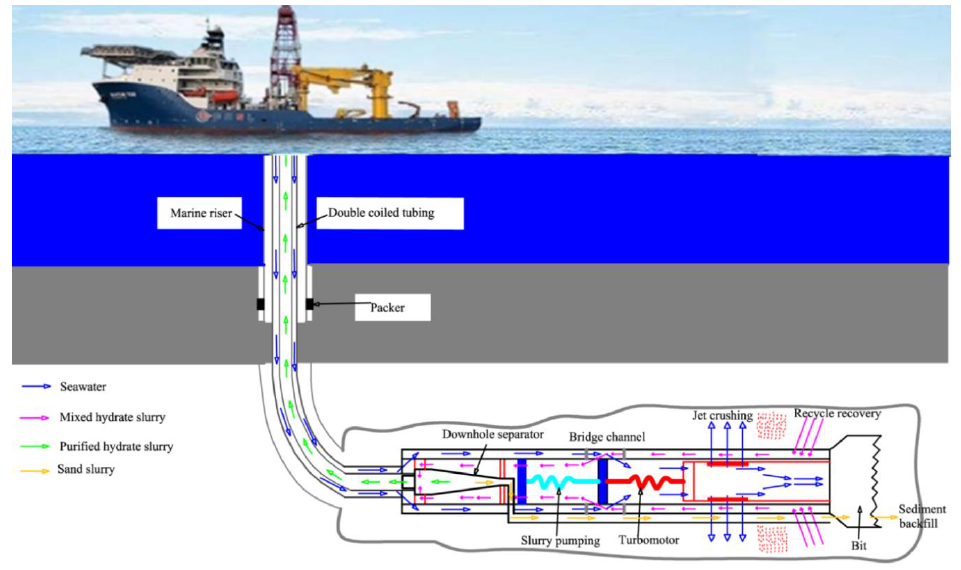
Figure 1. The exploitation process of natural gas hydrate (NGH) with the solid fluidization method. (Adapted from Qiu [17])